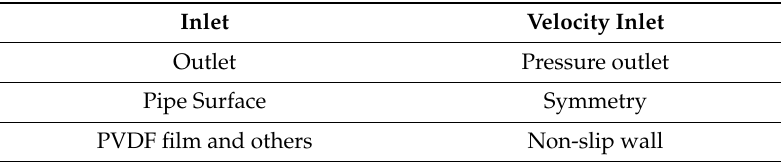
Table 1. Definition of boundary conditions.